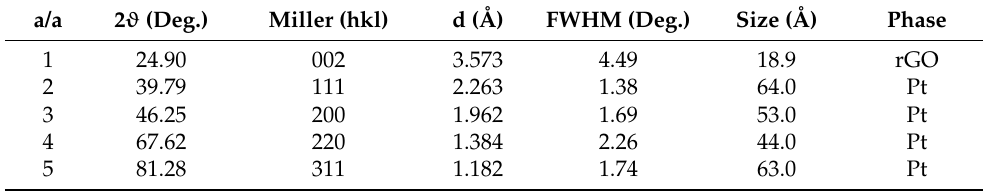
Figure 8. XRD spectra for Pt-decorated rGO [34]. Table 4. XRD peak